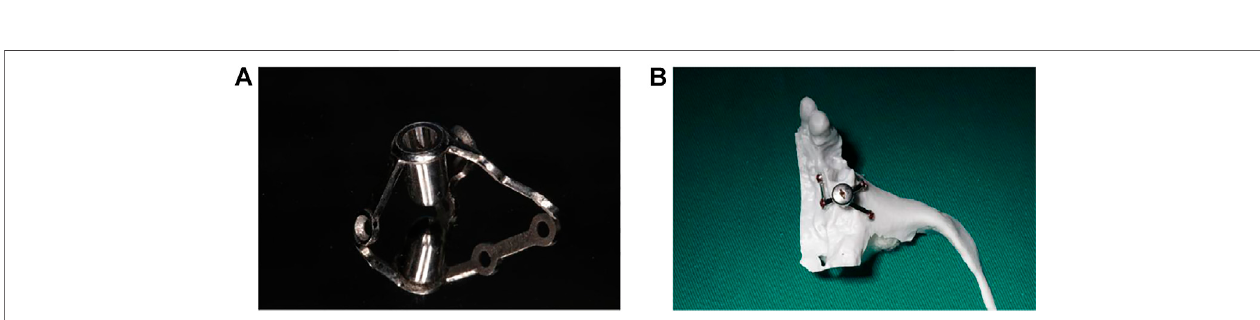
FIGURE 4 | The custom-made implant and 3D printed model of the bone. (A) The custom-made implant. (B) The custom-made implant on a 3D bone reconstruction resin model.